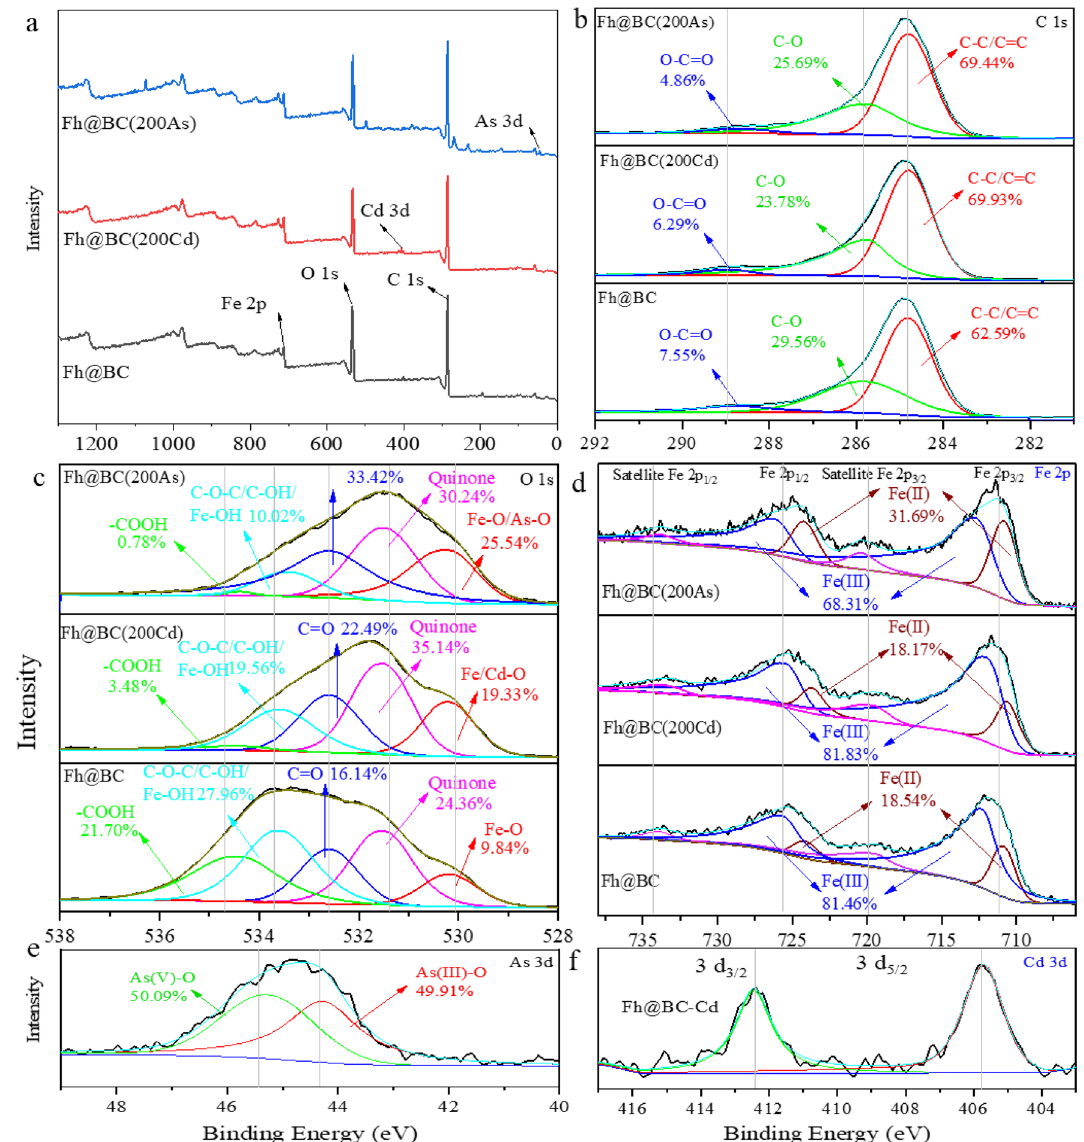
Figure 5. XPS spectrum of Fh@BC before and after the adsorption of As(III) and Cd(II). Fh@BC(200Cd) and Fh@BC(200As) represent the adsorption of Fh@BC for Cd(II) of 200 mg L −1 and As(III) of 200 mg L −1 , respectively. The symbols of ( b – f ) represent the XPS spectra of C 1s, O 1s, Fe 2P, Cd 3d, and As 3d,